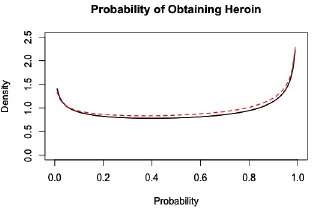
Figure 3. Distribution of the probability of being arrested. The black line represents the density of arrest probability across all customers within each 1-hour interval of market activity based on 100 simulations of the market from days 180 to 365. The dashed red line represents a fitted distribution, which is a Beta (0.43,1500) distribution.